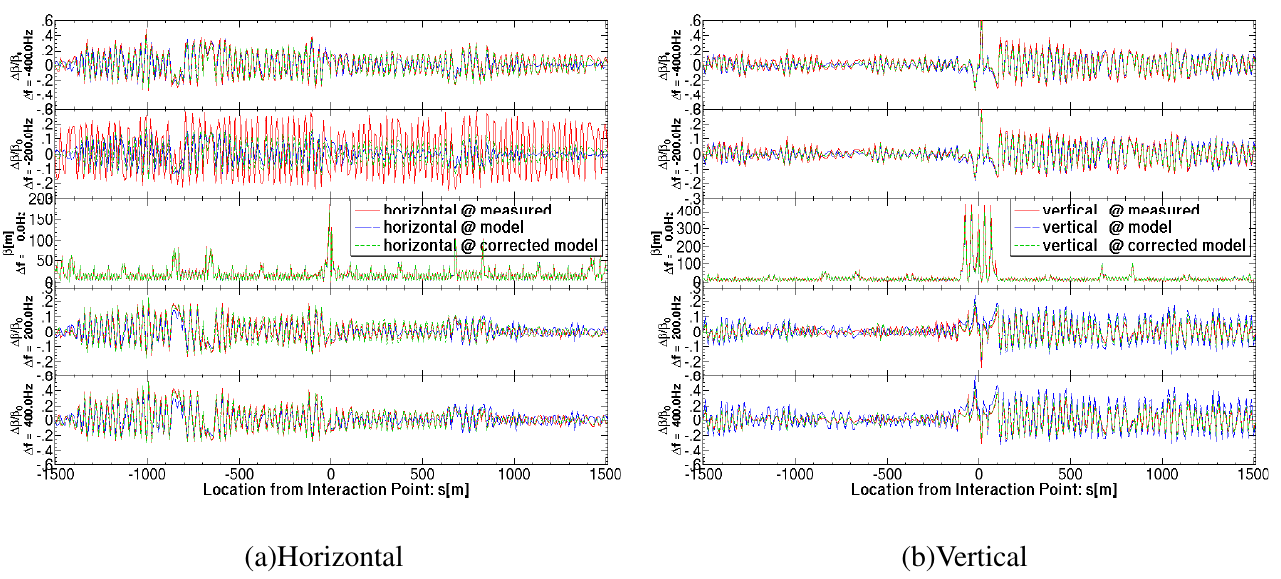
FIG. 3. (Color) Measured and model beta functions of the KEKB LER on November 12, 2005. The 3rd row shows the beta function, while the other rows show the chromatic deviations of the beta function. In these plots, red solid line, blue dashed line, and green dotted line correspond to the measurement, model before the correction, and model after the correction,